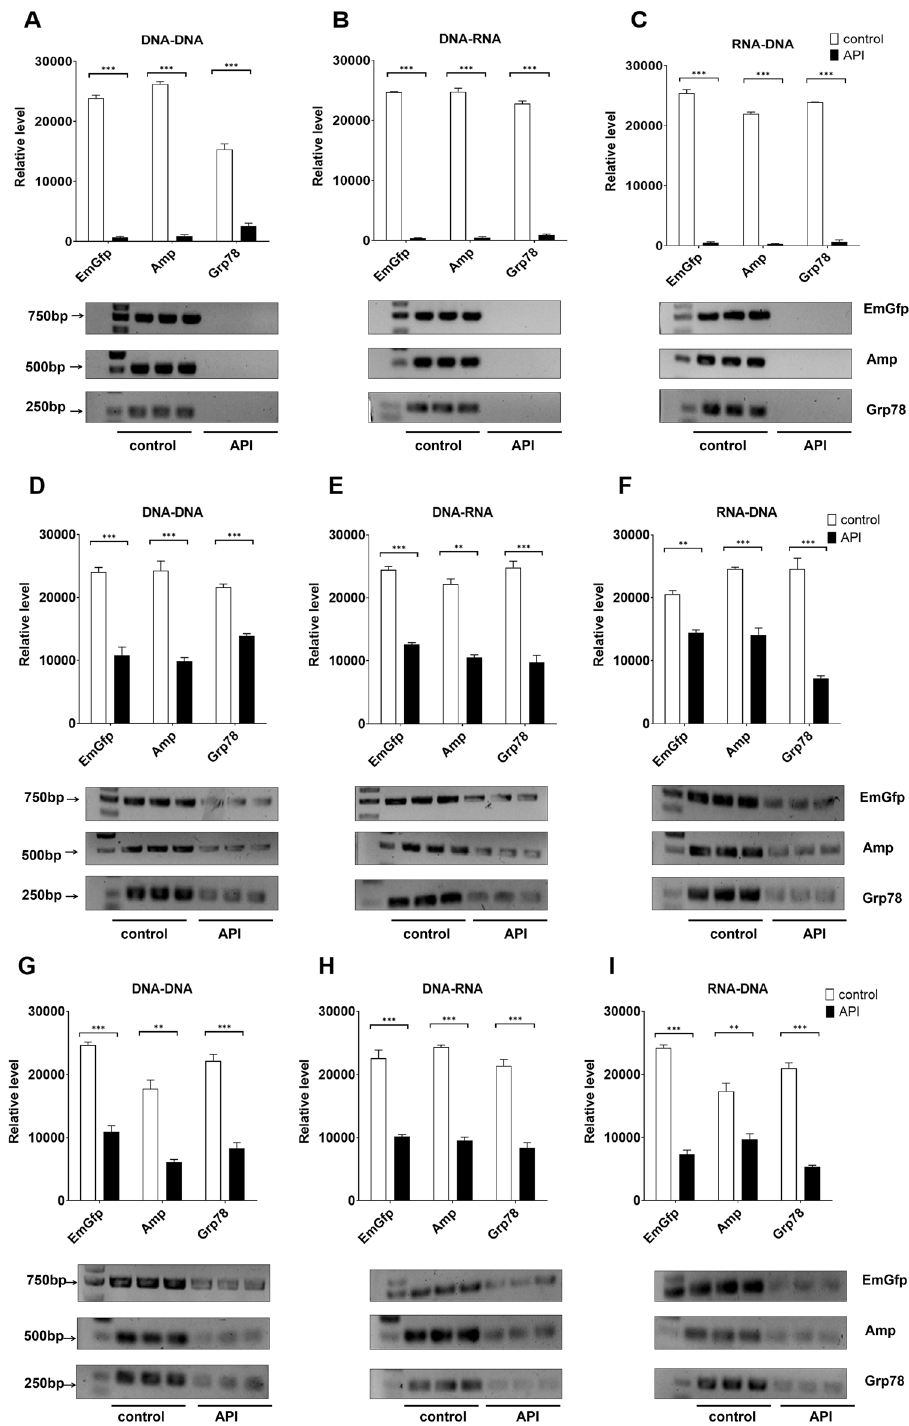
Figure 6. After lysozyme API gavage, rabbit gastric juice and jejunum fluid alter EmGfp, Amp and Grp78 DNA replication, transcription and reverse transcription in vitro. ( A )–( I ) Gel electrophoresis of PCR products. Lavage fluid of the gastric juices ( A )–( C ) and the upper ( D )–( F ) and lower ( G )–( I ) jejunum were added to the reaction system: ( A / D / G ) replication, ( B / E / H ) transcription and ( C / F / I ) reverse transcription. Intensity analysis of target bands in gel electrophoresis is shown at the top of the blot. Data are representative of 2 independent experiments and presented as the mean ± SD; * p < 0.05, *** p < 0.001. Significant differences were evaluated using one-way ANOVA with a post hoc test (Fisher’s least significant